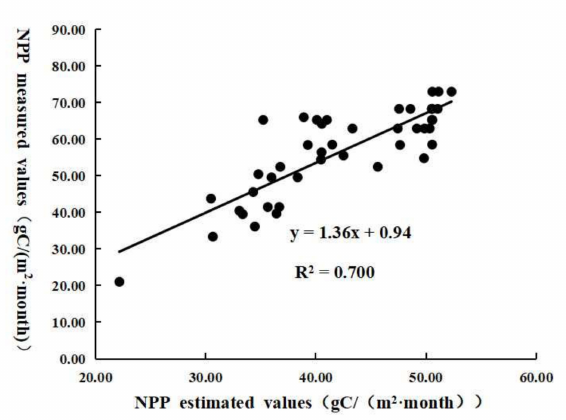
Figure 2. Net primary productivity model accuracy